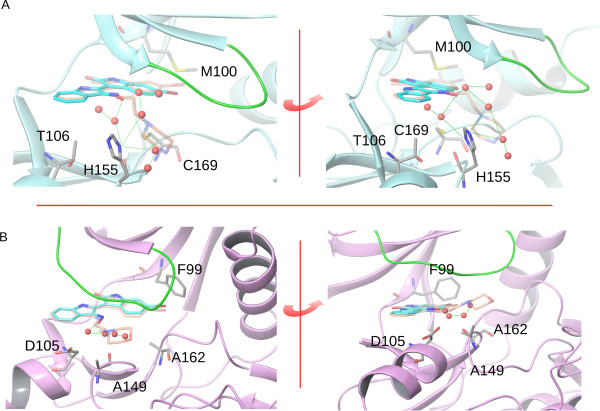
Comparison of the binding pocket entrance hydration sites as mapped using Szmap algorithm between the leishmanialLGSK-3 andLCRK3. Hydration sites with positive free energy as determined by Szmap computational analysis are depicted as red spheres in a ribbon representation of the protein. The hydration sites are connected with green lines depicting potential hydrogen bond networks that could be formed between them and neighboring residues. The depicted hydration sites potentially overlap with the bulky 3'-substituents of 6BIO analogues like those of compounds 11 and 17. Displacement and release of those water molecules by the compounds would favor binding affinity through the anticipated entropic gain. A) In LGSK-3, the indirubin substituent of position 3' occupies a region which overlaps with several unstable water molecules of the protein hydration shell. B) In LCRK3, the corresponding cluster of unstable water molecules is smaller and has a markedly lower overlap with the region occupied by the 3' substituent. As a result, binding affinity is not expected to be affected seriously by their displacement. In both figures, residues that differ between LGSK-3 and LCRK3 active sites are shown in stick representation and labelled (numbering based on L. donovani sequences). The ribbon fragments corresponding to the glycine-rich loop are colored green. The poses of analogues 11 and 17 are depicted as semi-transparent overlays on the 6BIO binding pose. For reasons of clarity and given that the poses of 11 and 17 are highly similar for each kinase, inhibitor 11 is depicted only in Figure 4A and inhibitor 17 in Figure 4B.